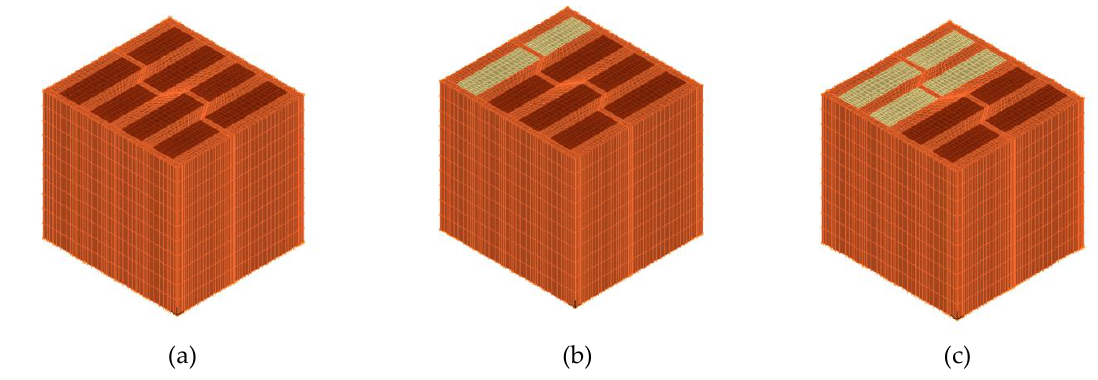
Figure 6. View of the model after discretization — ( a ) option 1; ( b ) option 2; ( c ) option 3.